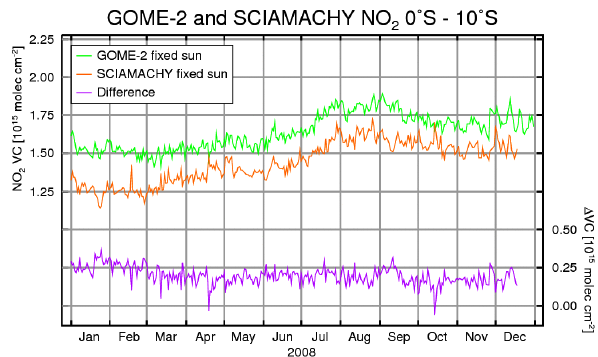
Fig. 12. Comparison of daily GOME-2 (green) and SCIAMACHY (red) NO 2 over the Pacific (180 ◦ E–220 ◦ E, 10 ◦ S–0 ◦ S) using the same retrievals as in Fig. 11, but with solar irradiance measurements form 1 July 2008 as background spectrum. The difference of the two time series is also shown (pink).